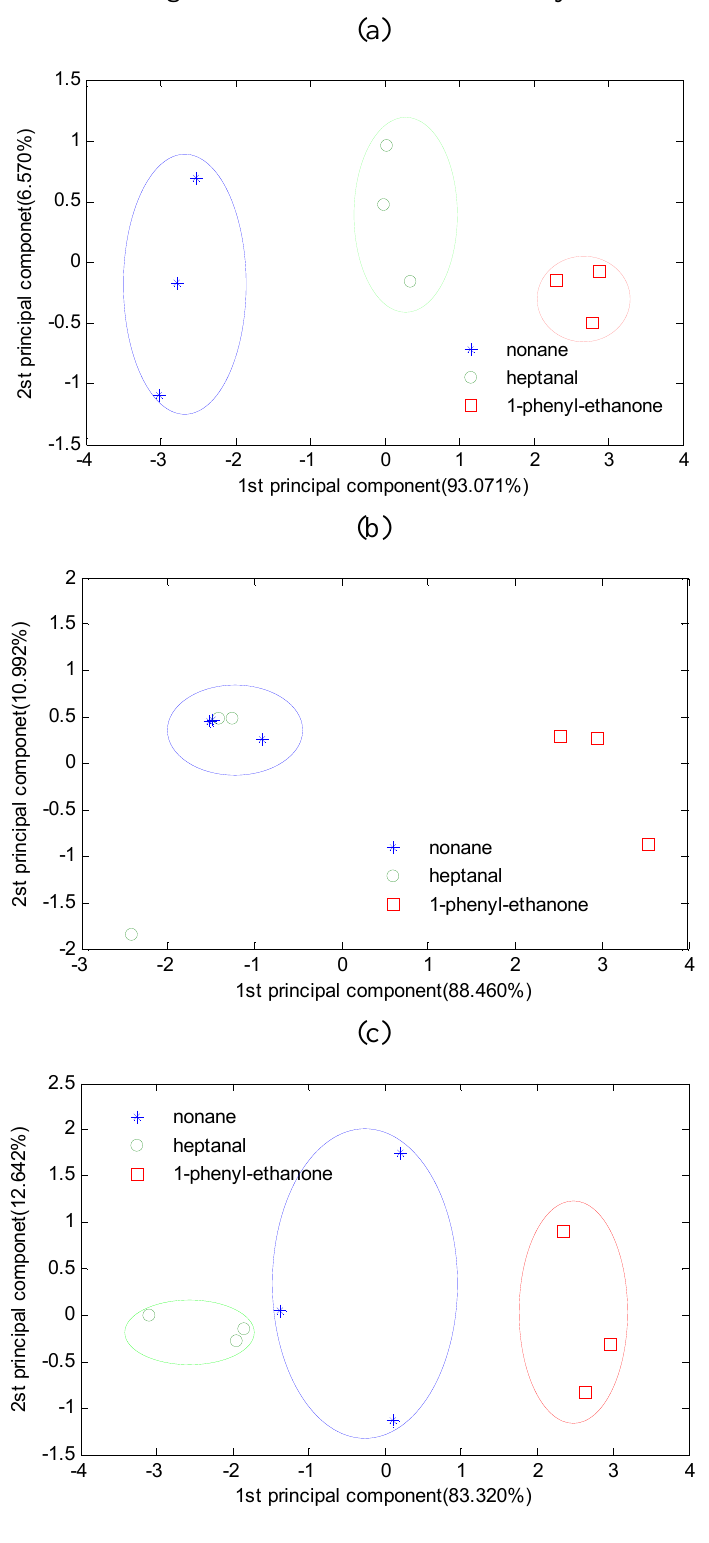
Figure 7. PCA of the three odorant gases sample strongly interfered by background factors. (a) Nine original samples can be classified correctly; (b) The interfered samples may cause overlap of nonane and heptanal samples; (c) The interfered samples can be classified correctly by gas condensation together with the electronic nose